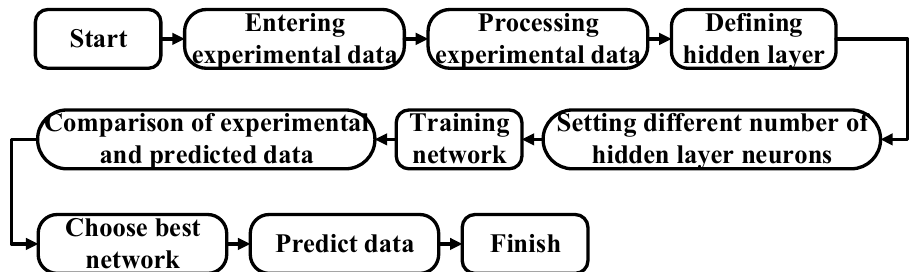
Figure 4. The flow chart for determining the optimal network Structure.